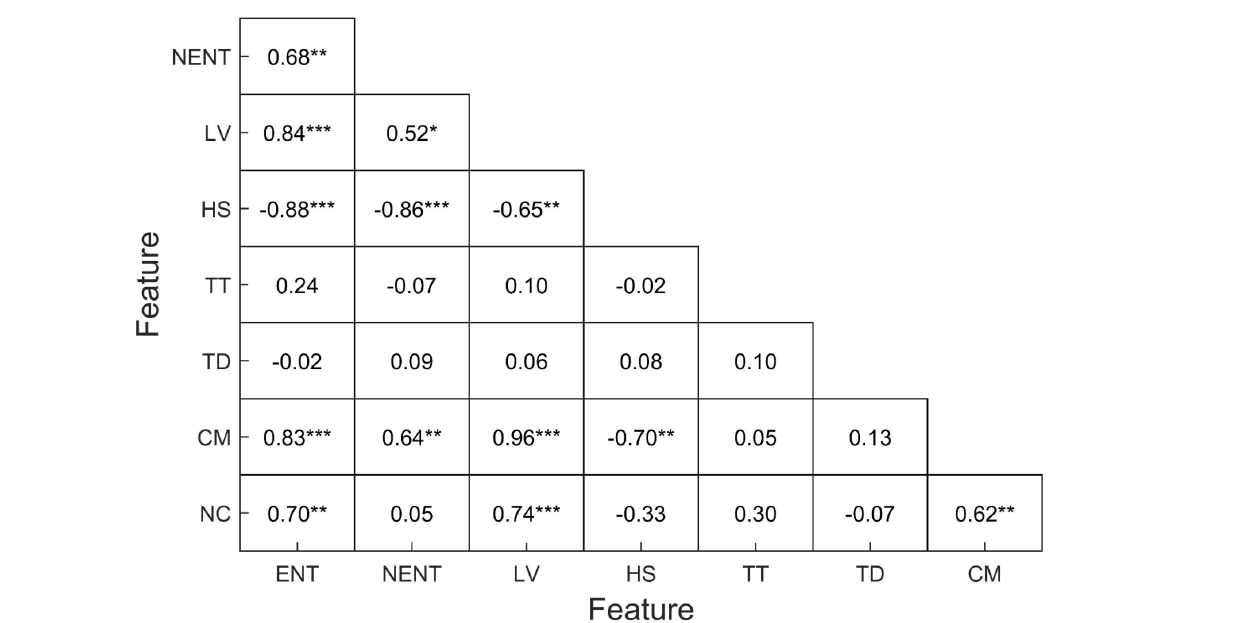
Figure 5. Coefficients of correlation between location features. One, two, and three asterisks indicate significant correlation levels at P<.05, P<.01, and P<.001, respectively (ENT, entropy; ENTN, normalized entropy; LV, location variance; HS, home stay; TT, transition time; TD, total distance; CM, circadian movement; NC, number of